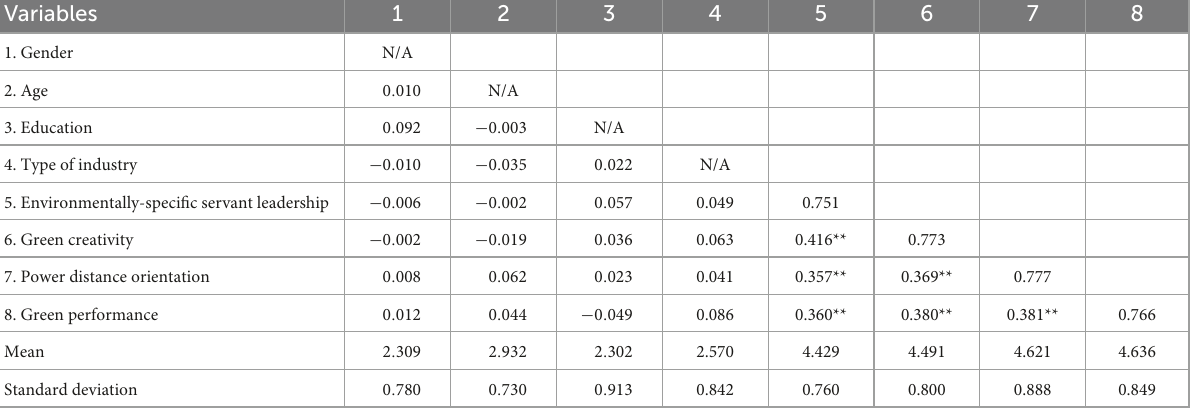
TABLE 4 Correlation analysis.